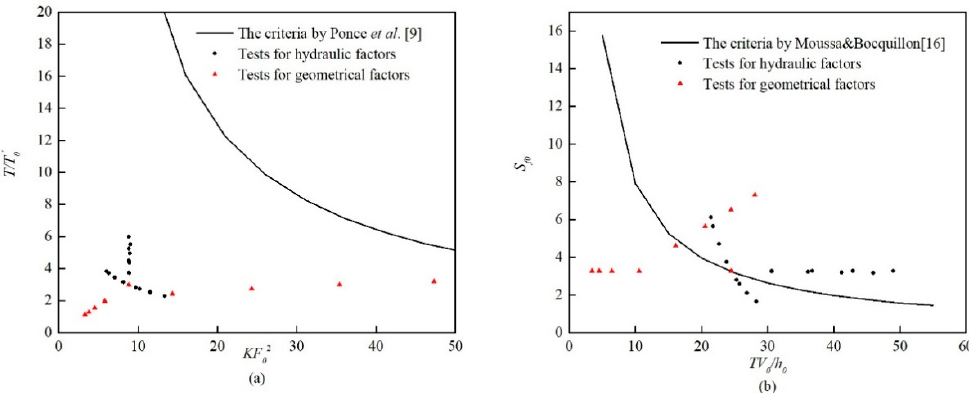
Figure 4. ( a ) The identification of the numerical tests by the criterion (the bound of 95% accuracy) of Ponce et al. [9]. ( b ) The identification of the numerical tests by the criterion (the bound of 95% accuracy) of Moussa and Bocquillon [16].